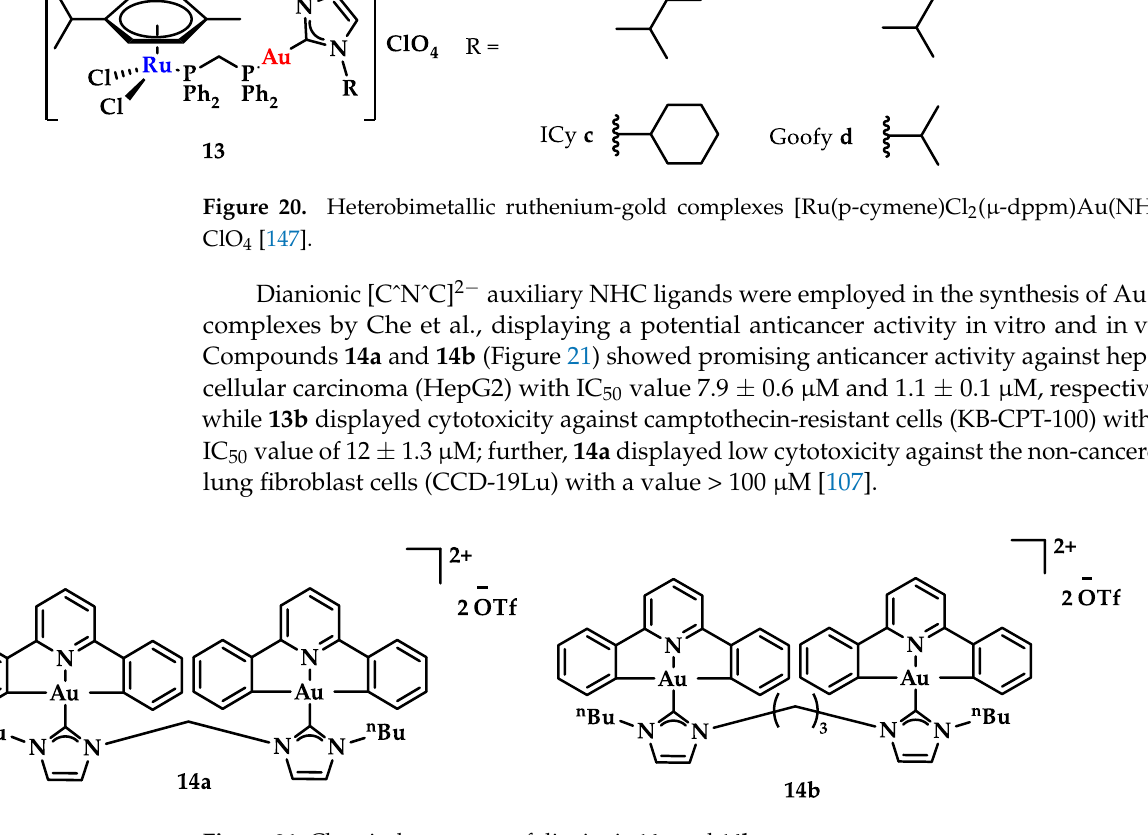
Figure 21. Chemical structures of dianionic 14a and 14b .